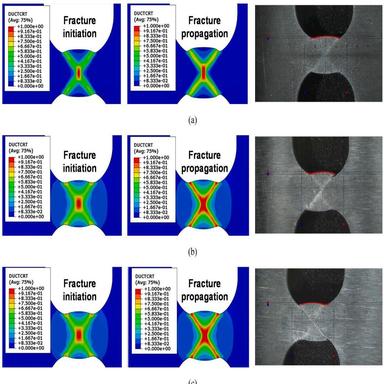
Damage index and compressive fractured specimen shape with (a) no pre-tensile strain, (b) pre-tensile strain of 0.079, and (c) pre-tensile strain of 0.093.